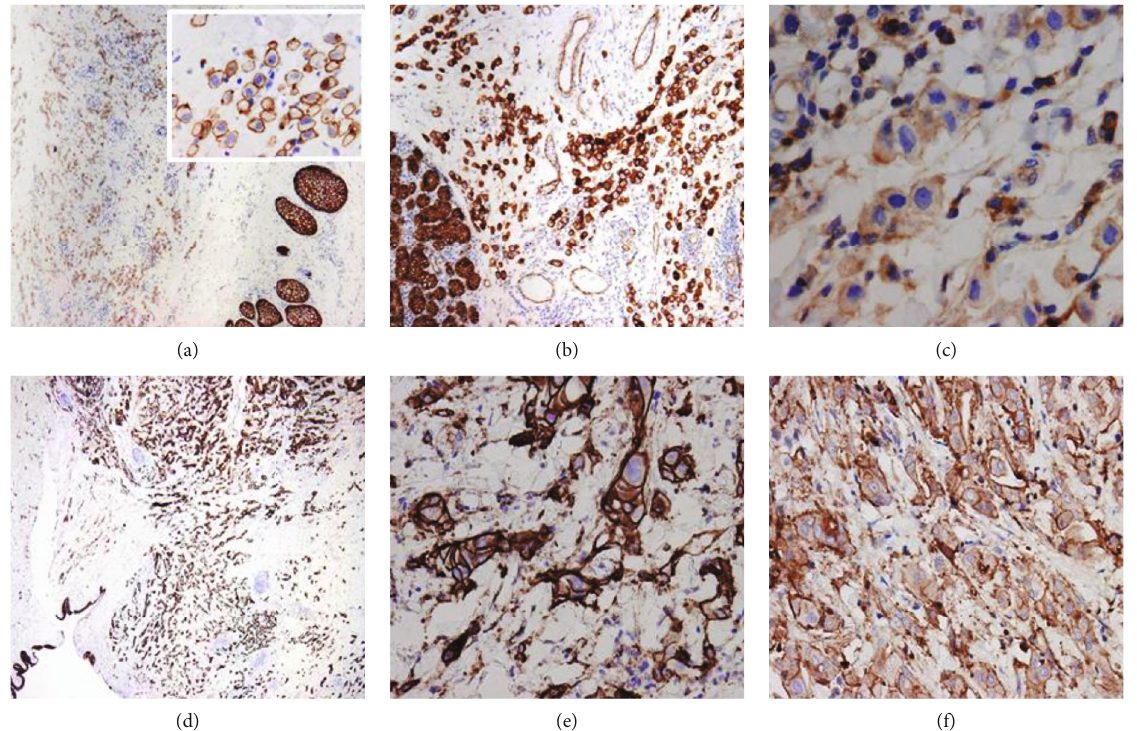
Figure 5: Case 3: (a) tumor cells and normal sebaceous glands retain positive staining for E-cadherin (inset: depicting complete membranous staining; 20x); (b) tumor cells and lacrimal gland acini show uniform, membranous β -catenin staining (10x); (c) high cytoplasmic/membranous staining for Src is identi fi ed in > 50% of tumor cells (20x). Case 4: (d) strong E-cadherin expression is present (4x); (e) strong membranous and cytoplasmic staining for β -catenin (20x); (f) increased cytoplasmic expression of Src is noted in > 50% of tumor cells